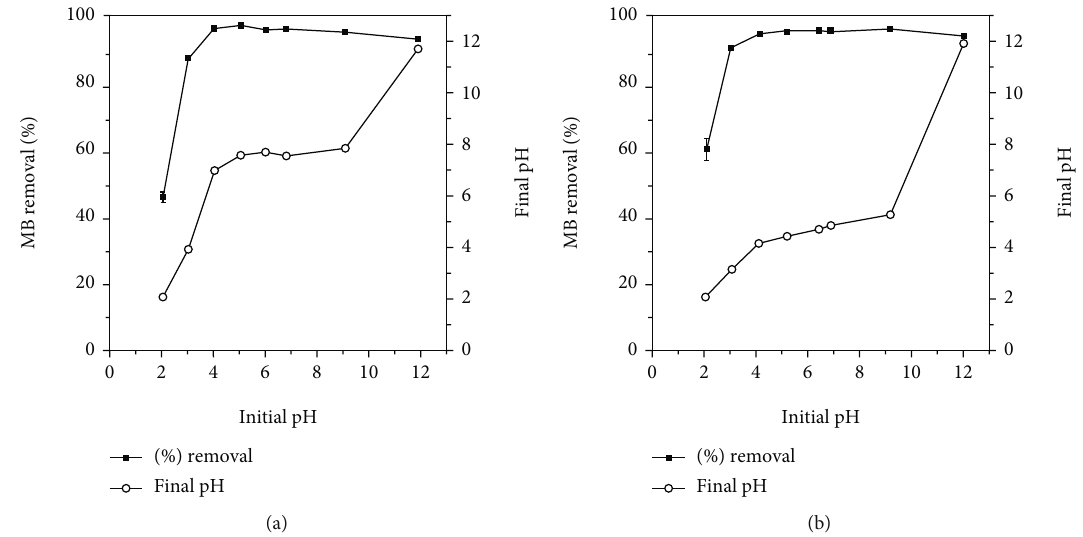
Figure 7: E ff ect of solution pH on the adsorption of MB onto (a) BB and (b) EVML (conditions: initial concentration 10mg/LMB, adsorbent dose 2.5g/L, shaking speed 200 rpm, and temperature 25 ± 1 ° C